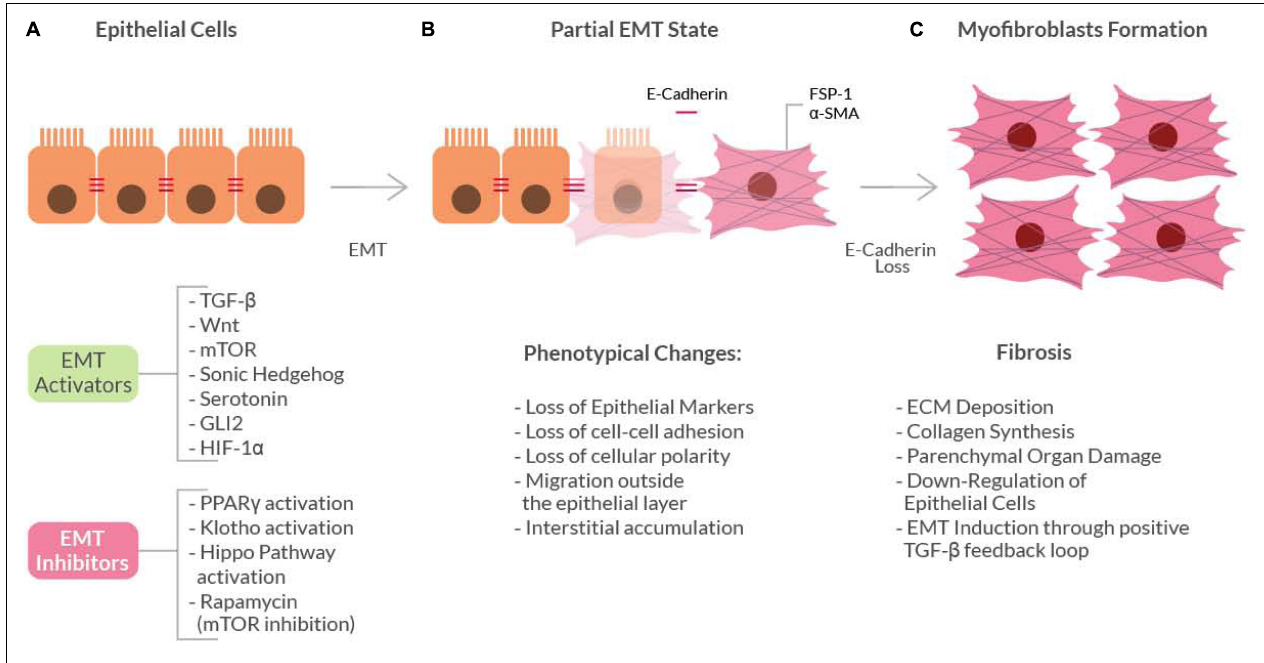
FIGURE 1 | Schematic diagram showing the basic mechanism of the Epithelial-to-Mesenchymal Transition (EMT). Epithelial cells (A) can undergo EMT when stimulated by EMT-activators. These activators induce initial phenotypical changes (gray box) that leads to a ‘partial EMT’ state (B) , in which both epithelial and mesenchymal markers are expressed. The continuous pro-EMT stimuli can ultimately cause the loss of E-cadherin thus inducing the epithelial cells to acquire a full myofibroblast phenotype (C) and ultimately the fibrotic